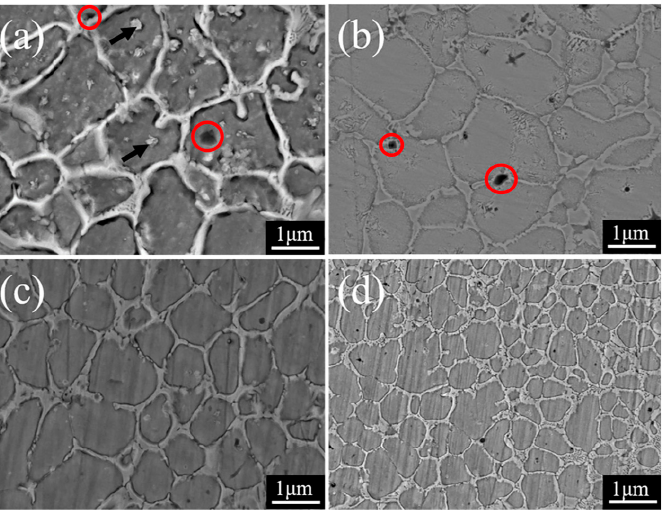
Figure 13. SEM micrographs of MgMoNbFeTi 2 Y x HEAs ( a ) x = 0, ( b ) x = 0.4%, ( c ) x = 0.8%, ( d ) x = 1.2%. The black arrows in Figure 13a show the particles of iron, magnesium and yttrium oxides. The red circles in Figure 13a,b mark black particles of intermetallic compounds. Reprinted with permission from Ref. [78]. Copyright 2020